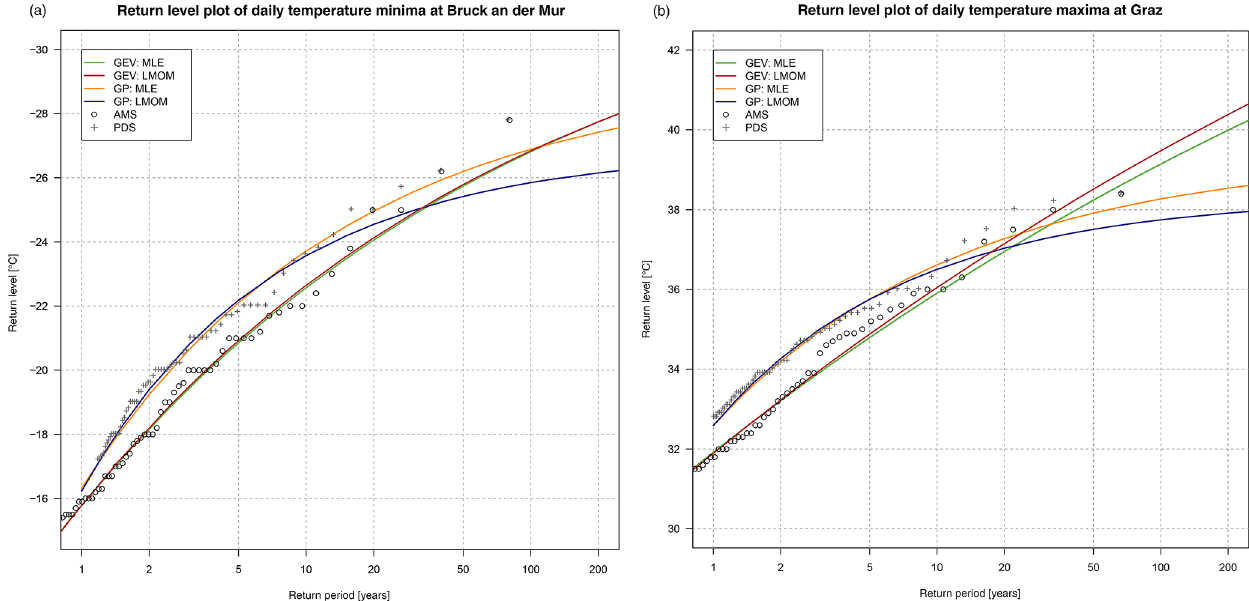
Figure 7. Return level plots of (a) temperature minima at Bruck an der Mur and (b) temperature maxima at Graz. Return level estimation is based on the block maxima approach and on the threshold excess approach with two different parameter estimation methods (MLE and LMOM estimation). Based on the CRMSE 10 , GP fitted on the basis of MLE was found to be the most appropriate method for both Bruck an der Mur and